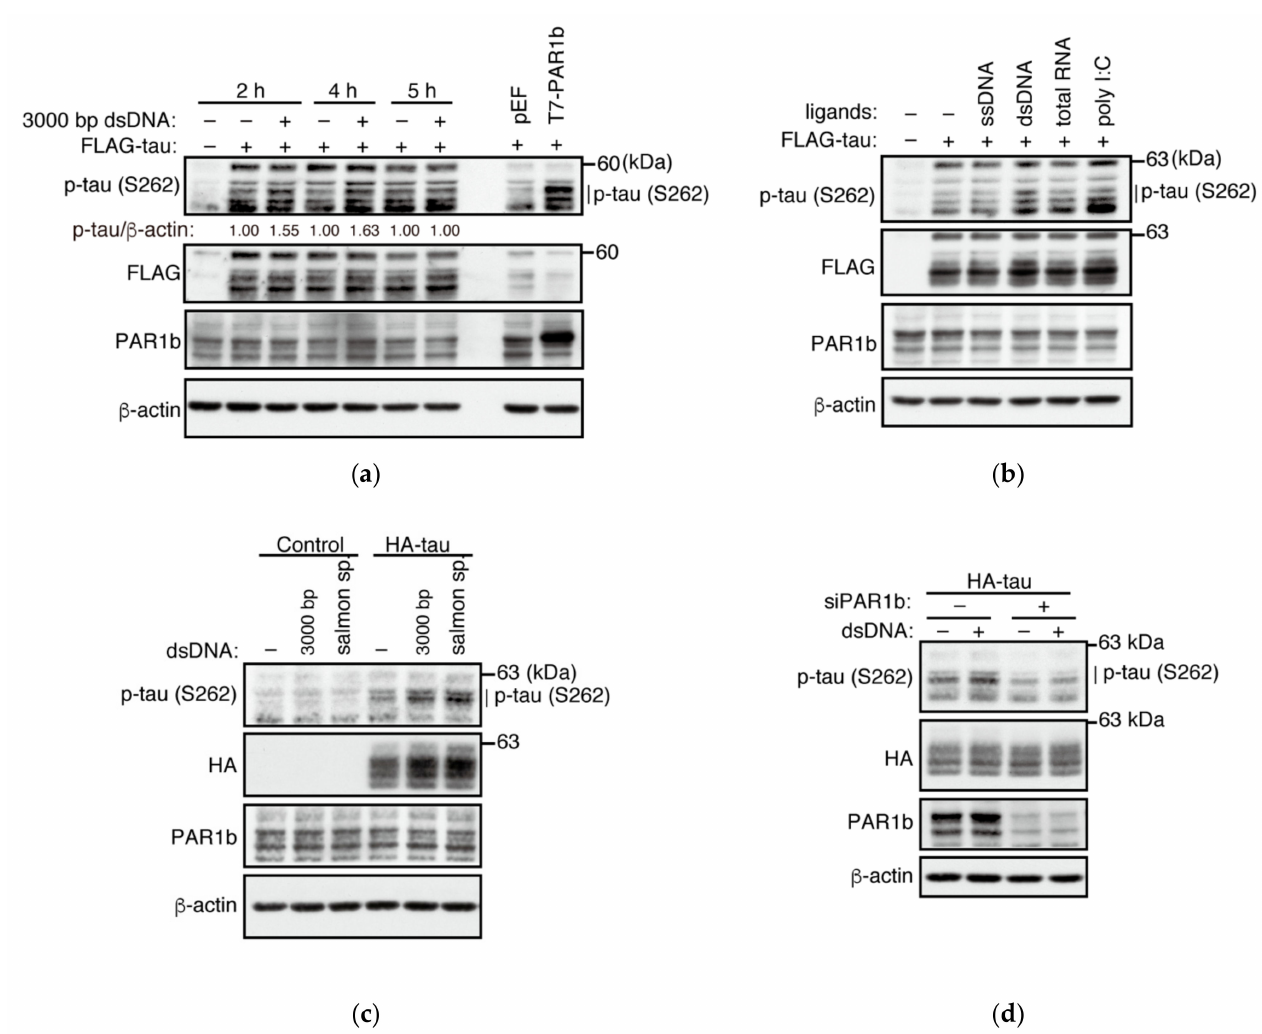
Figure 5. Nucleic acids can enhance the kinase activity of PAR1b in the cell. ( a ) Transfection of dsDNA induces phosphorylation of tau at S262 in cells in a time-dependent manner. AGS cells were transiently transfected with an expression vector for FLAG-tau. After 24 h, cells were transfected with 2 µ g/mL linearized 3000 bp dsDNA for 2, 4 and 5 h before cell lysis. Cells co-transfected with expression vectors for FLAG-tau and T7-PAR1b are used as positive control ( final lane ). Phosphorylation of tau was quantified with an image analyzer and normalized to its control at each time point. ( b ) The effect of various nucleic acid ligands on the phosphorylation of tau. AGS cells were transiently transfected with an expression vector for FLAG-tau followed by transfection with 2 µ g/mL of ssDNA from salmon sperm, dsDNA from salmon sperm, total RNA from AGS cells or poly I:C for 2 h. ( c ) dsDNA induces phosphorylation of tau in AGS cells stably expressing HA-tau. The stable cell line was transfected with 2 µ g/mL linearized 3000 bp dsDNA or dsDNA from salmon sperm. ( d ) Phosphorylation of tau at S262 is dependent on PAR1b. AGS cells stably expressing HA-tau were treated with PAR1b-specific siRNA for 48 h and then transfected with 2 µ g/mL dsDNA from salmon sperm for 2